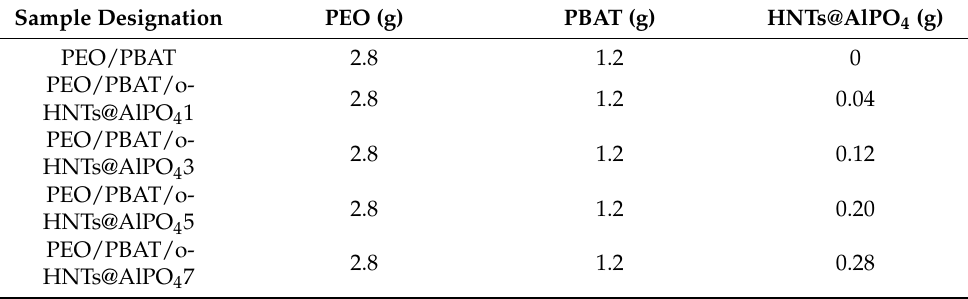
Table 2. Formulations of the PEO/PBAT/o-HNTs@AlPO 4